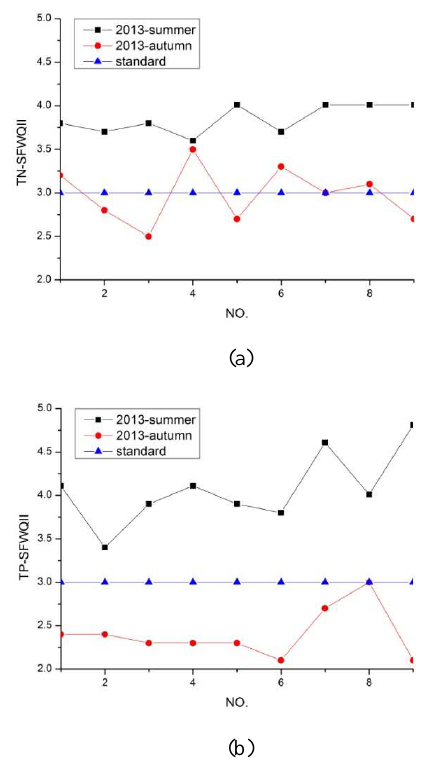
Figure1. Statistical results of SFWQII of TN and TP in the study area, (a)